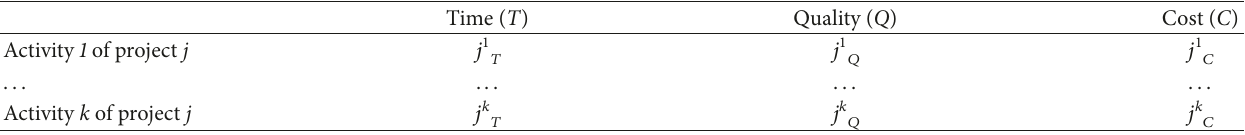
Table 1: The planned value of the activity.